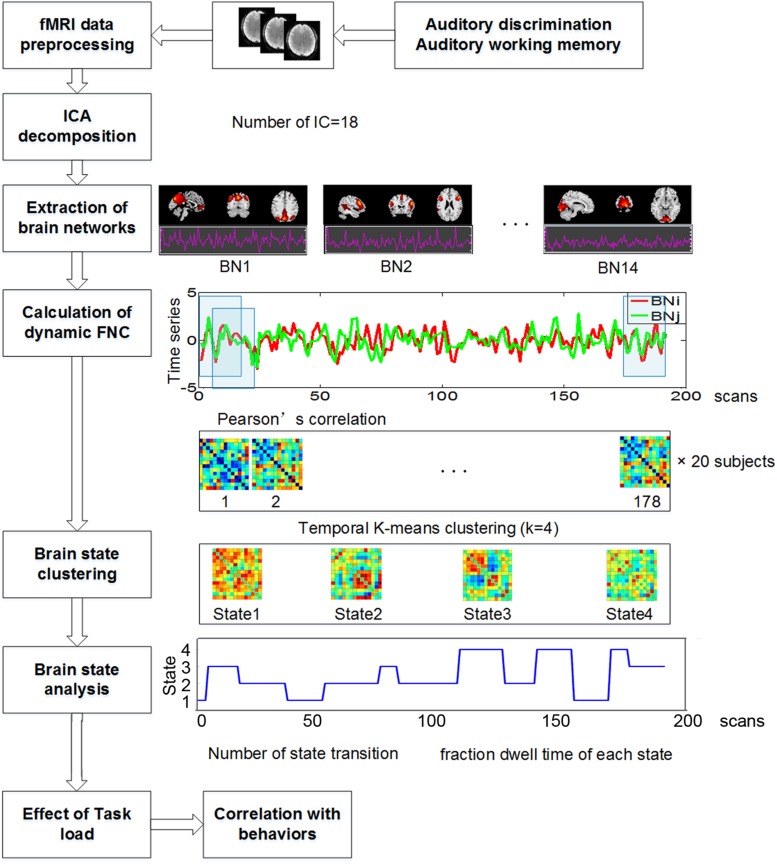
The whole data processing steps.